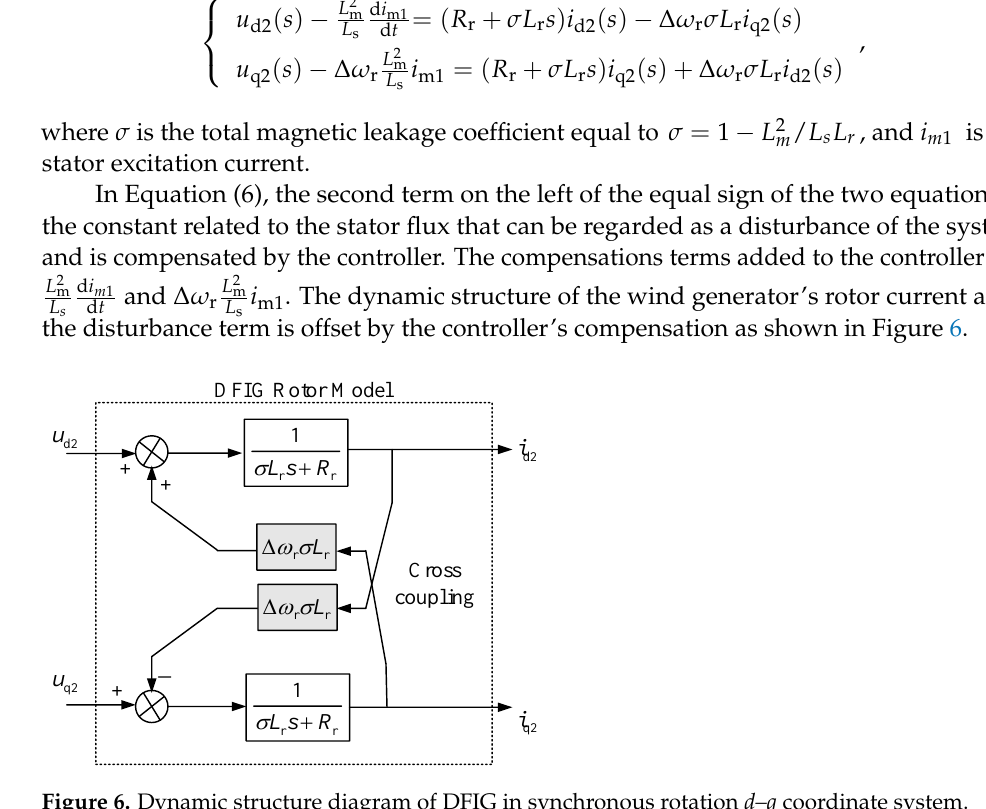
Figure 6. Dynamic structure diagram of DFIG in synchronous rotation d – q coordinate system. A cross-coupling term between the d -axis and q -axis components of the rotor current in the generator can be seen in Figure 6. This indicates that the two components cannot be independently adjusted and affects the electromagnetic torque and speed performance of the generator. Hence, it is necessary to decouple the cross-coupling of the wind